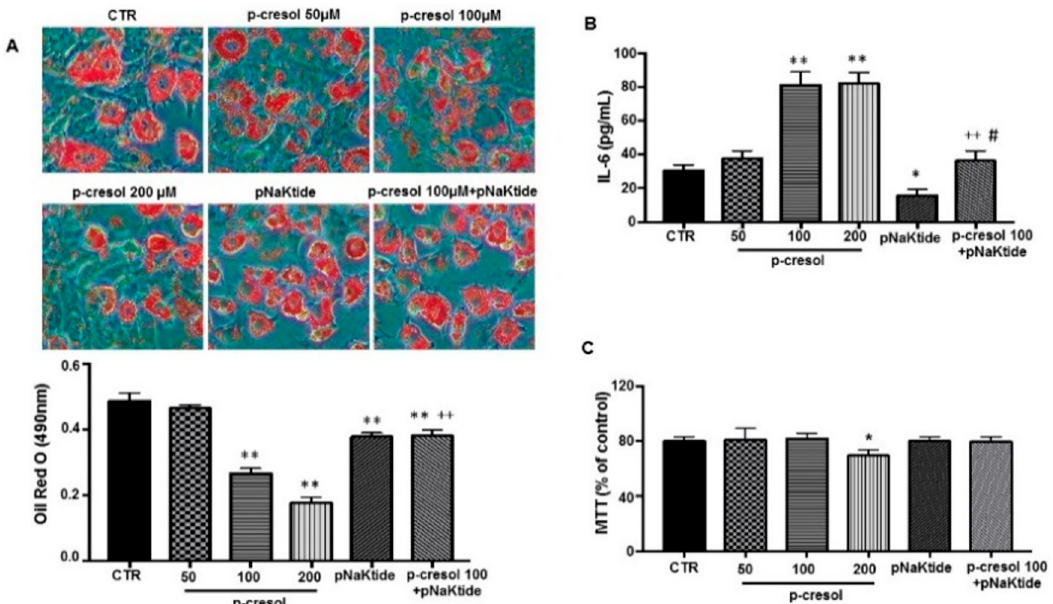
Figure 3. Dose-dependent effect of p-cresol exposed to 3T3-L1 murine pre-adipocytes and treated with or without pNaKtide. ( A ) Representative images and quantitative data of adipogenesis measured as the relative absorbance of Oil Red O. Images taken with 40 × objective lens; ( B ) quantitative analysis of pro-inflammatory cytokine IL-6; and ( C ) MTT assay. Values represent means ± SEM ( n = 6). * p < 0.05 vs. CTR, ** p < 0.01 vs. CTR, ++ p < 0.01 vs. p-cresol 100 µ M, # p < 0.05 vs. pNaKtide.